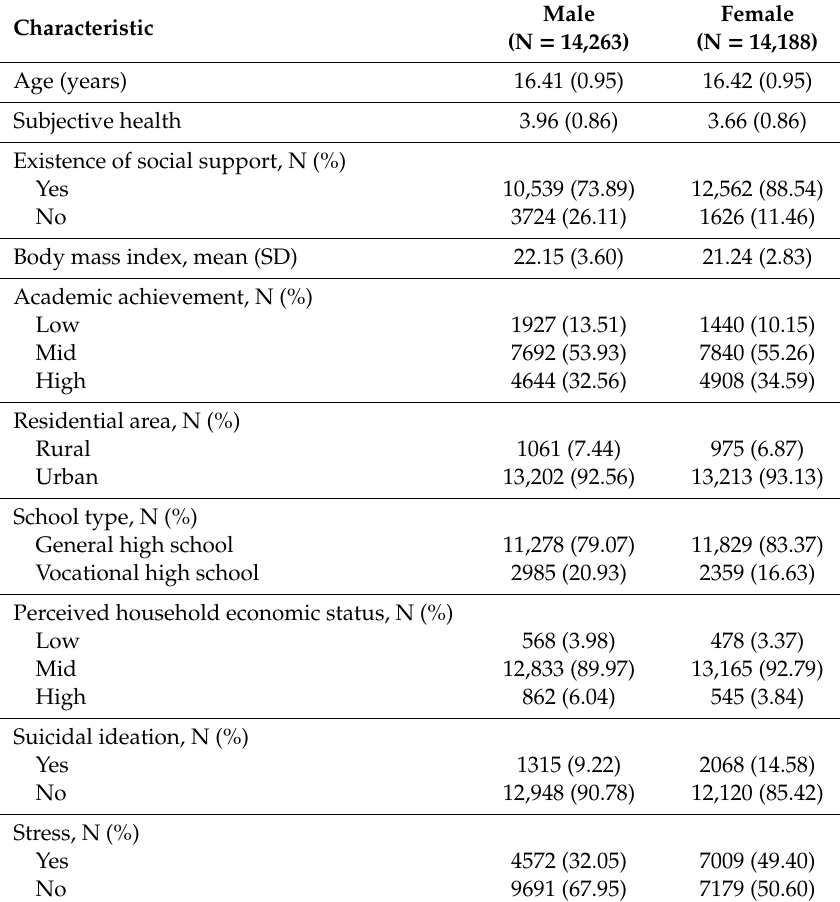
Table 1. Characteristics of students (N =